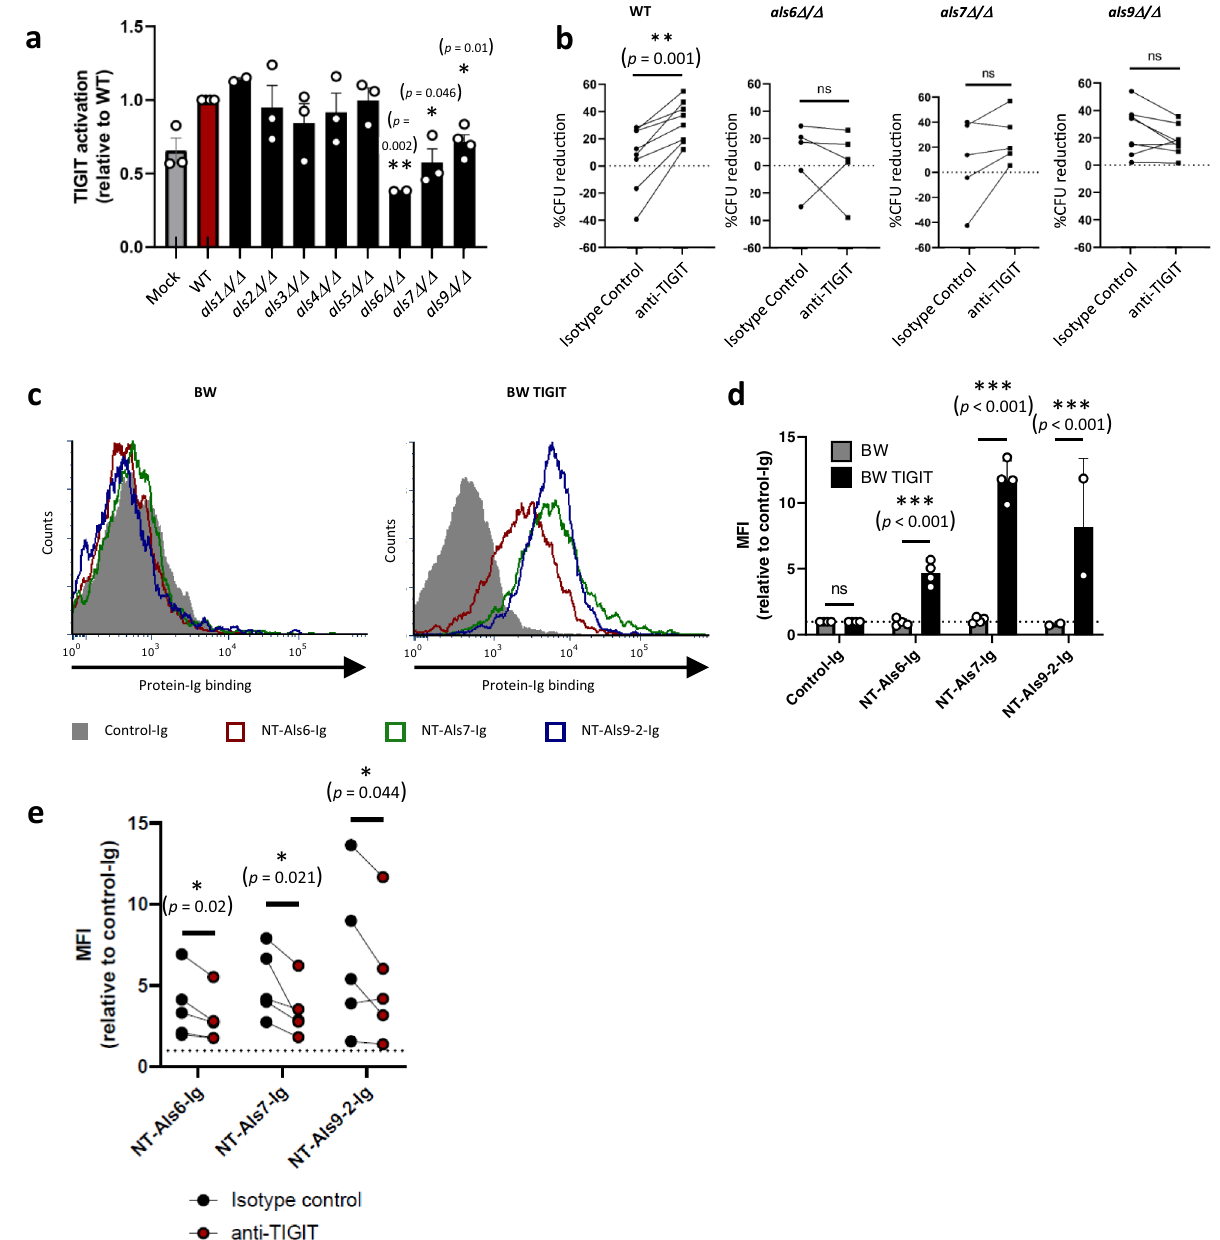
Fig. 3 Als proteins of C. albicans are fungal TIGIT ligands. a TIGIT activation was assayed using the murine thymoma cell line BW expressing a chimeric TIGIT- ζ -chain receptor. The BW cells were co-incubated for 48 h in the presence or absence of the WT C. albicans strain SC5314 or mutant strains deleted for members of the Als protein family. TIGIT activation was measured using ELISA for IL-2 secreted by the activated BW cells. n = 2 – 4 independent experiments. Values are shown relative to the TIGIT activation abilities of the WT strain. b Cytotoxicity assay of C. albicans strain SC5314 or mutant strains deleted for members of the Als protein family using primary NK cells isolated from different human donors. The NK cells were blocked or not using an anti- TIGIT antibody. Each line represents a different human donor. c Flow cytometry staining of BW and BW TIGIT cells using NT-Als6-Ig (red empty histogram), NT-Als7-Ig (green empty histogram), NT-Als9-2-Ig (blue empty histogram) or a negative control protein ( fi lled gray histogram). One representative experiment out of 2 – 4 is presented. d Quanti fi cation of the results presented in ( c ). n = 2 – 4 independent experiments. Data are presented as mean values ± SEM. e Quanti fi cation of fl ow cytometry staining of BW TIGIT cells using either NT-Als6-Ig, NT-Als7-Ig, NT-Als9-2-Ig in the presence of an anti-TIGIT antibody (red dots) or an isotype control antibody (black dots). Each line represents an independent experiment. Error bars represent the standard error of the mean. Signi fi cance was tested using Student ’ s t test (two-tailed unpaired for ( a , d ), two-tailed and paired for ( b ), and one-tailed and paired for ( e )). ns = not-signi fi cant, * = p < 0.05, ** = p < 0.01, *** = p < strains als6 Δ / Δ , als7 Δ / Δ or als9 Δ / Δ , were not (Fig. 3b). As deletions of these Als proteins reduced the inhibitory effect of TIGIT activation to insigni fi cant levels, we conclude that they are TIGIT ligands expressed on C. albicans .